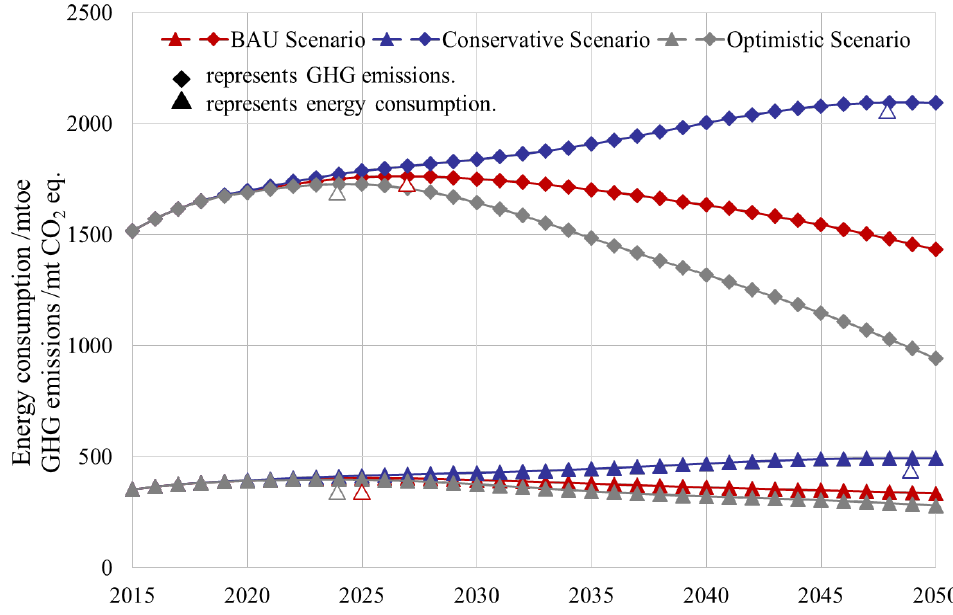
Figure 7. Energy consumption and GHG emissions under three different scenarios 2015–2050.